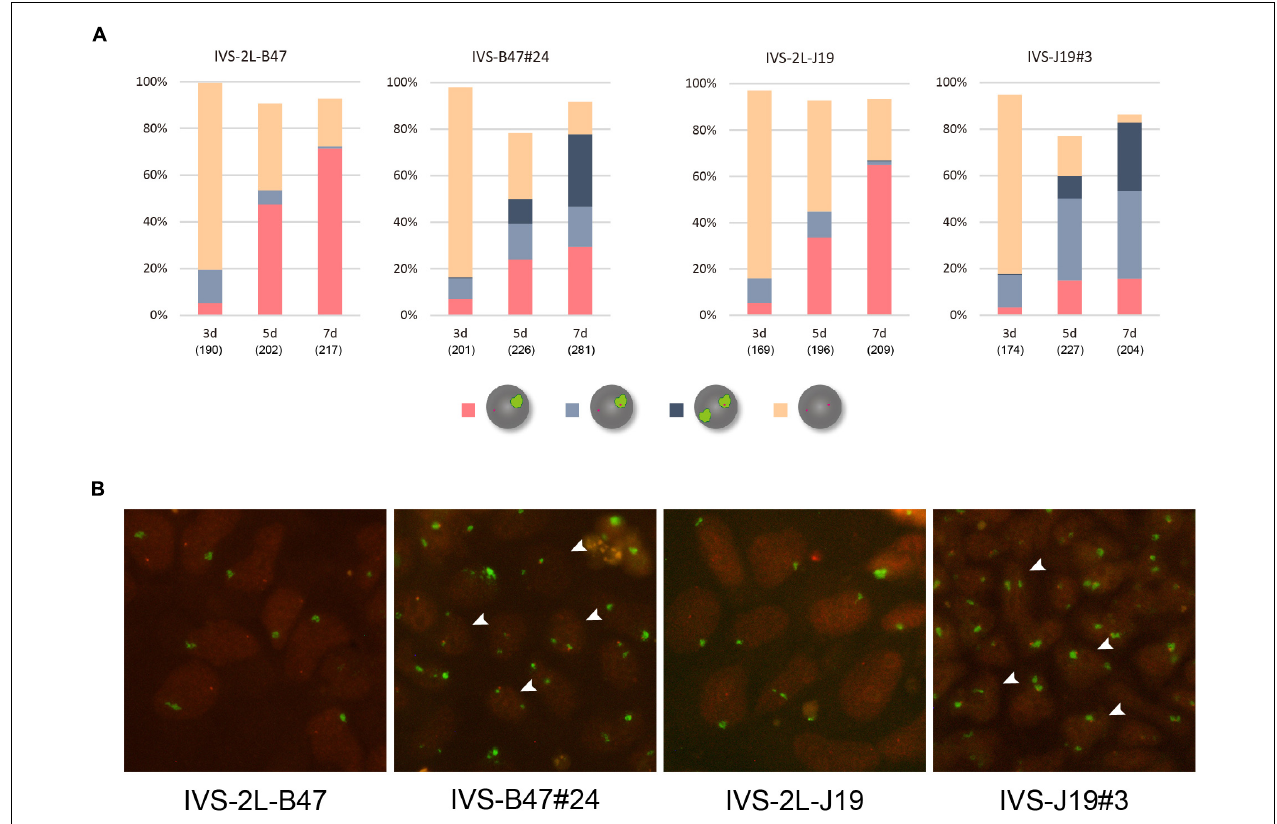
FIGURE 2 | RNA-FISH in differentiating ESCs heterozygous for either Xist CAGIVS 2 lox or Xist CAGIVS . (A) Expression of Xist and Atrx was examined in respective differentiating ESCs for day 3 (d3) up to day 7 (d7). IVS-2L-B47 and IVS-B47#24 carry the targeted Xist allele on the X B6 ; IVS-2L-J19 and IVS-J19#3 on the X JF1 . The number of nuclei examined is indicated in parentheses under each day point. (B) Representative images of RNA-FISH in each ESC line on d7. Xist in green and Atrx in red. Arrowhead indicates some of the nuclei containing two Xist clouds, one of which juxtaposes an Atrx